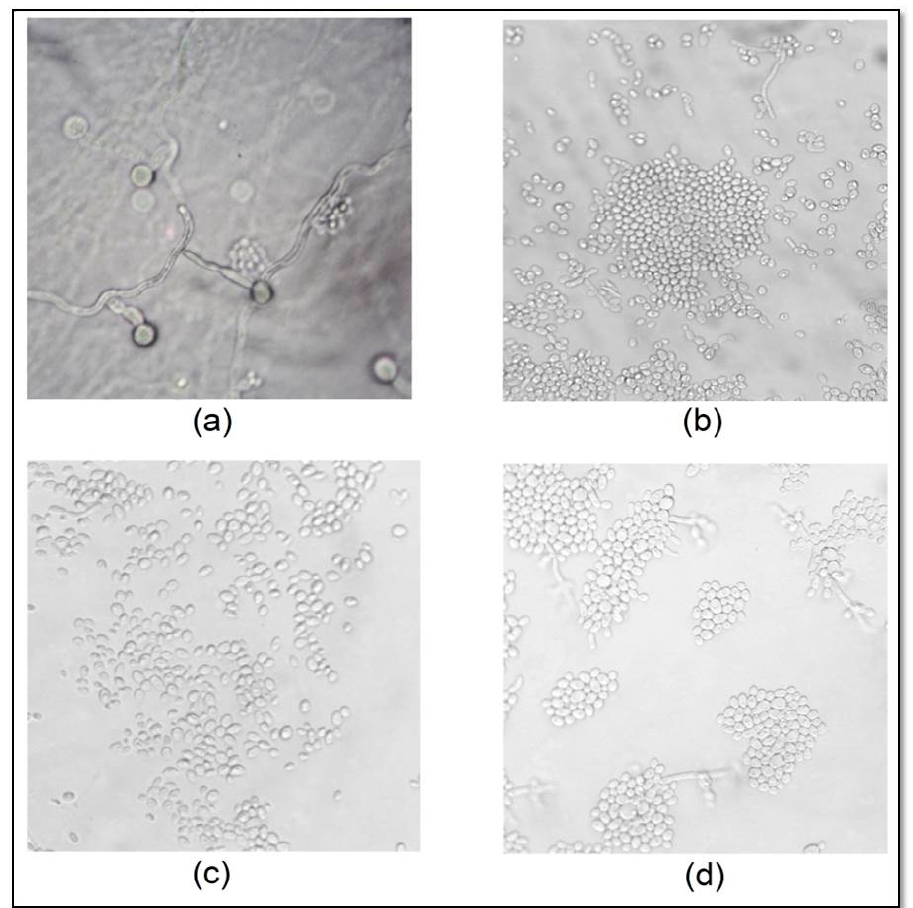
Figure 5. Candida albicans (CBS 562) micromorphology (40× magnification) in the absence (growth control) ( a ) and presence of chloramine T ( b ), sodium hypochlorite ( c ) and nystatin ( d ) at 2 × MIC.